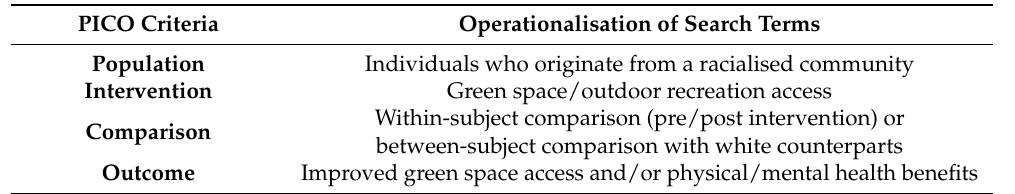
Table 1. Operationalisation of search terms using PICO framework. PICO Criteria Operationalisation of Search Terms Population Individuals who originate from a racialised community Intervention Green space/outdoor recreation access Within-subject comparison (pre/post intervention) or Comparison between-subject comparison with white counterparts Outcome Improved green space access and/or physical/mental health benefits Key search terms included synonyms and terms around; individuals/families